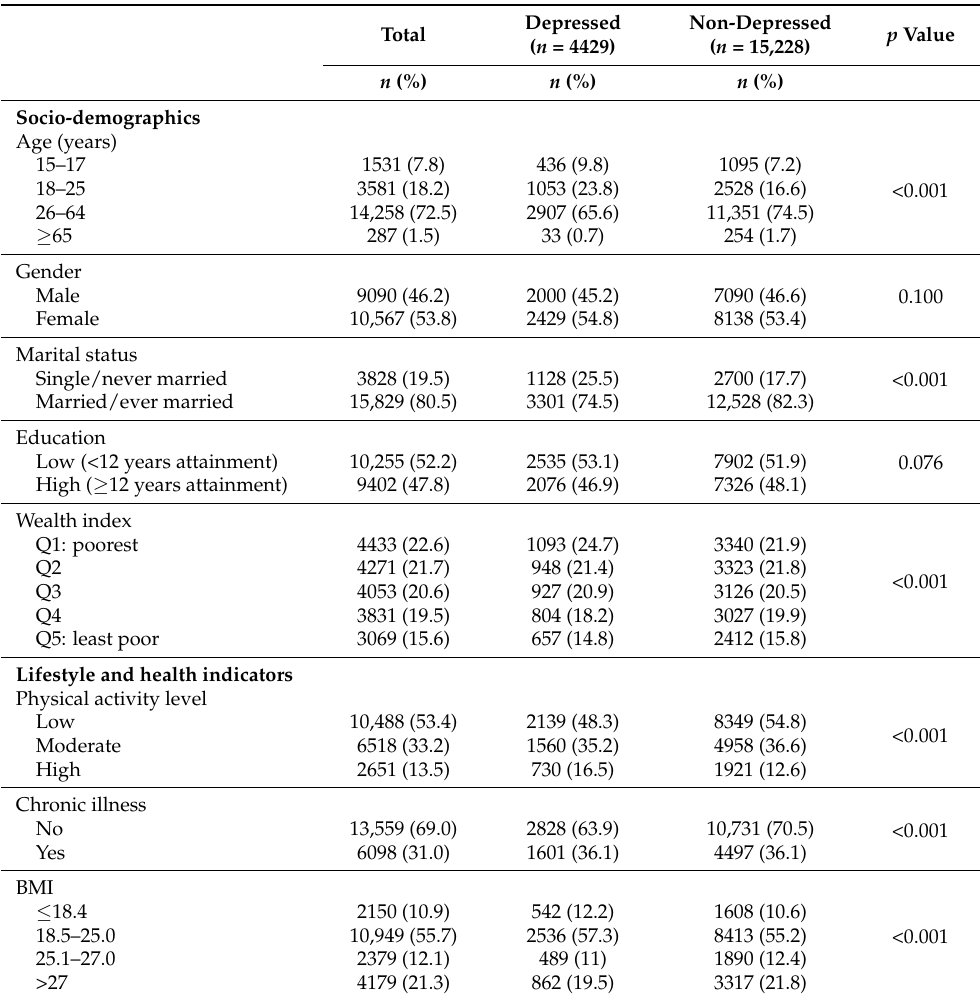
Table 1. Variables for participants with and without depressive symptoms ( n =